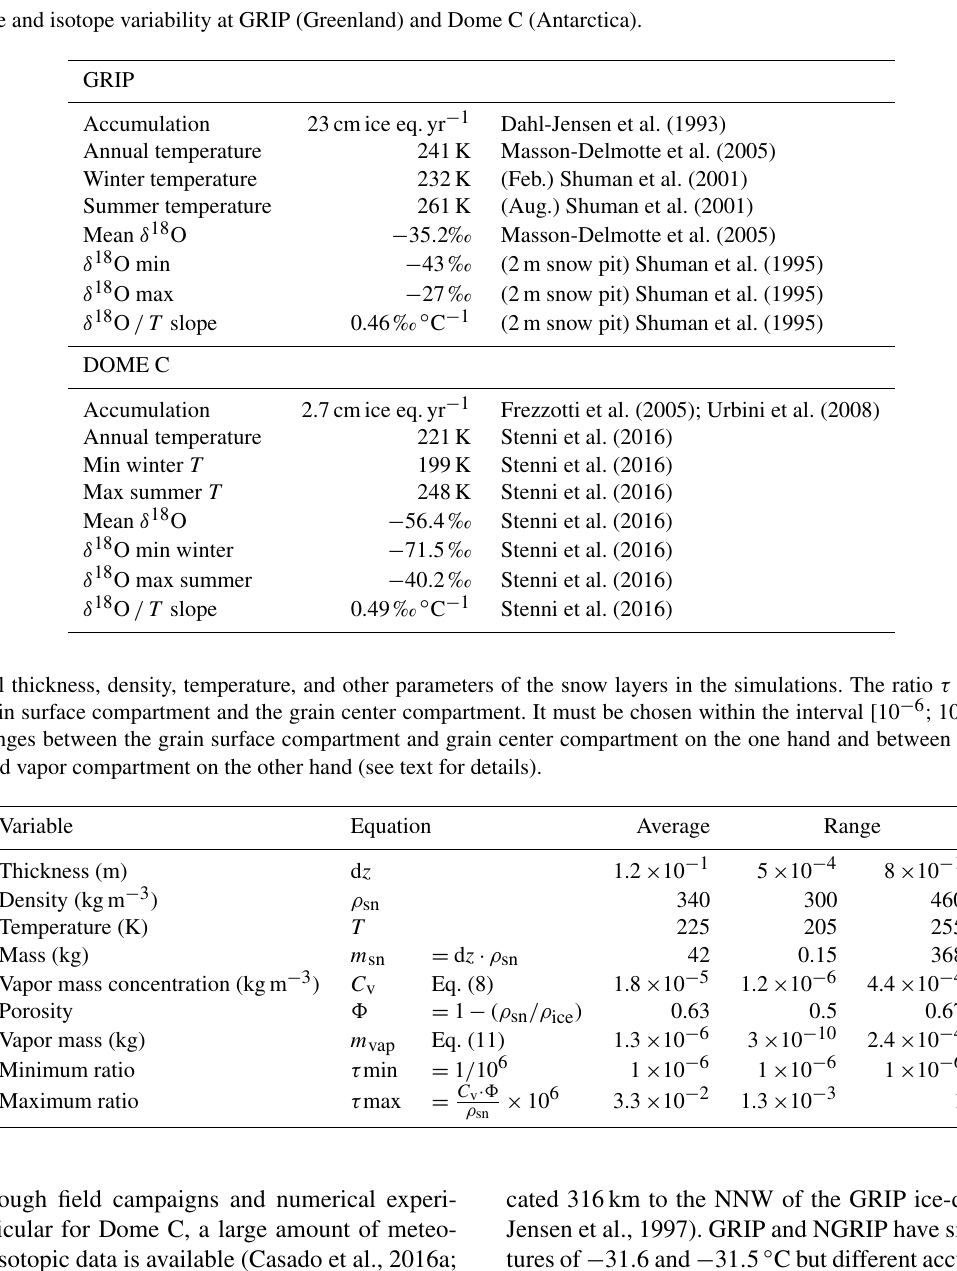
Table 2. Climate and isotope variability at GRIP (Greenland) and Dome C (Antarctica).